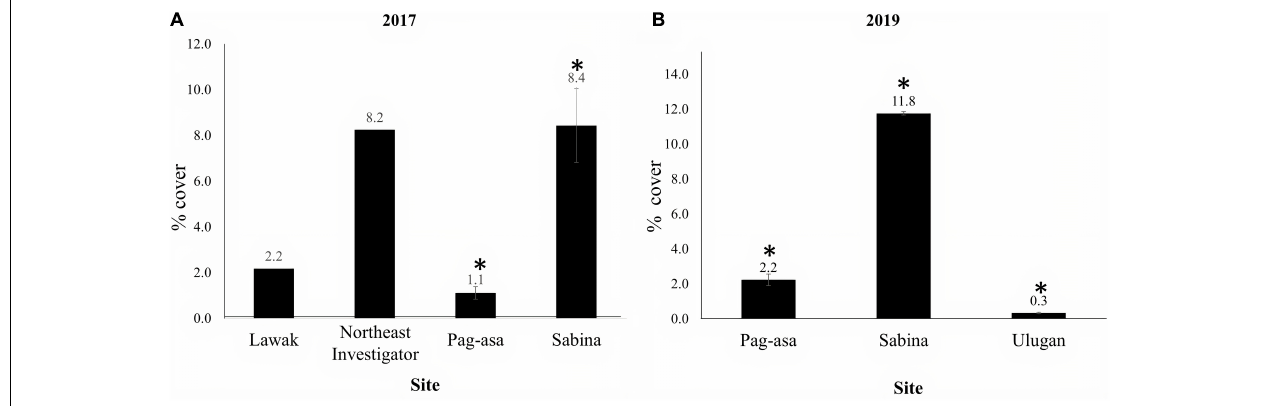
FIGURE 2 | Octocoral cover (mean ± SE) of the sites in the Kalayaan Island Group (Pag-asa, Sabina, Lawak and Northeast Investigator) and Ulugan surveyed in (A) 2017 and (B) 2019. Asterisks (*) indicate significant difference ( p -value < 0.05). Lawak and Northeast Investigator were not included in the among-sites analyses due to lack of replicates.